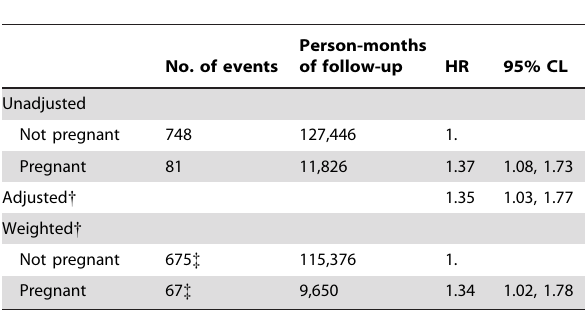
Table 3. This model showed that older age, baseline employment status, and lower BMI were associated with lower HR for virologic failure; and that lower CD4 count, use of nevirapine (compared with efavirenz), and less-than-perfect adherence were associated with higher HRs for virologic failure.